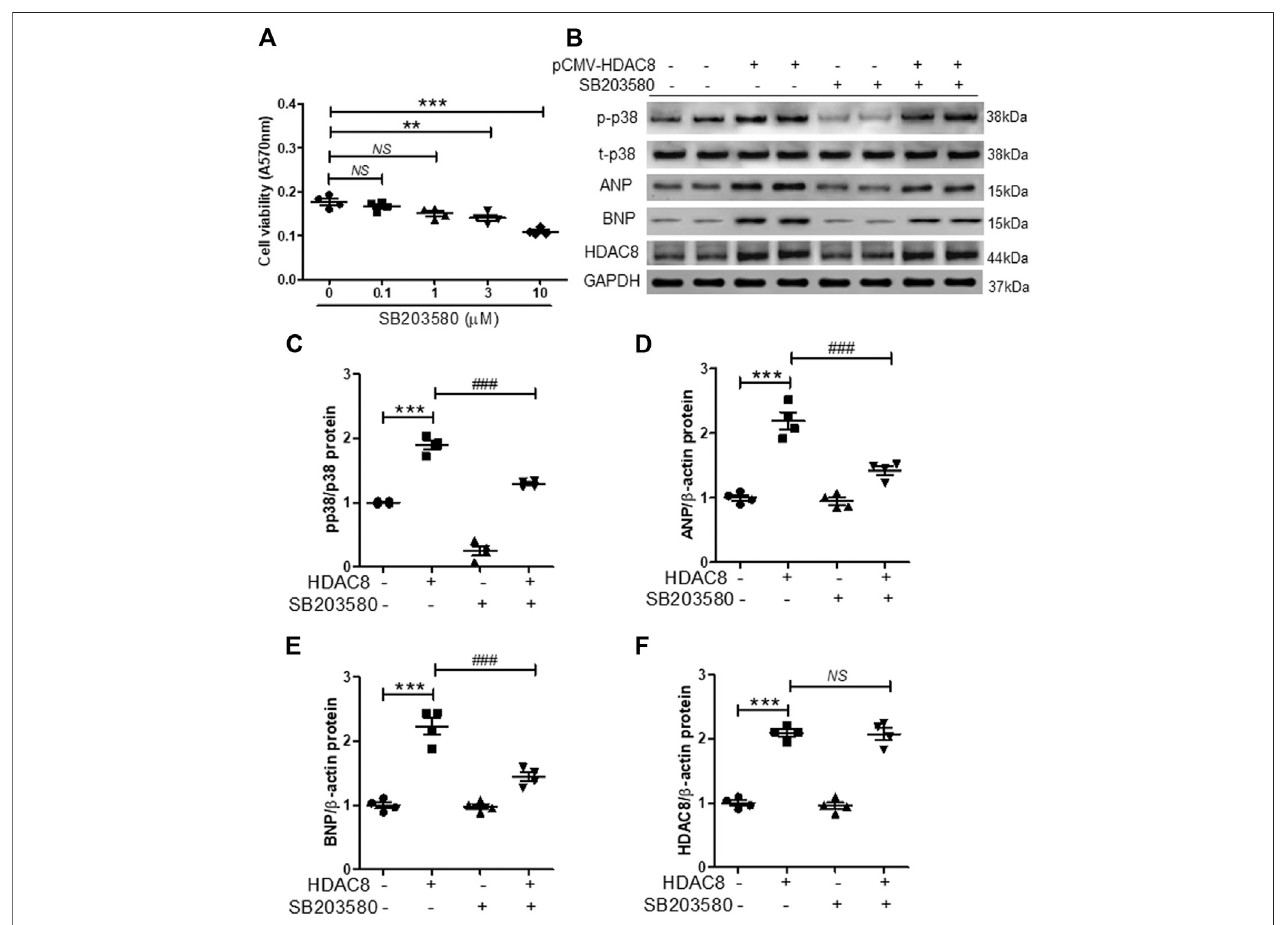
FIGURE 7 | Inhibition of p38 MAPK reduces the expression of cardiac hypertrophic markers induced by HDAC8 overexpression (A) H9c2 cells were treated with SB203580 (0.1, 1, 3, and 10 μ M) for 24 h and cell viability was evaluated ( n (cid:2) 4). ** p < 0.01 and *** p < 0.001. NS (cid:2) not signi fi cant (B) H9c2 cells were transfected with either pCMV6-HA-Myc or pCMV6-HDAC8-HA-Myc and treated with SB203580 (1 μ M) for 24 h. Representative western blot images of p-p38, t-p38, ANP, BNP, and HDAC8 (C − F) Quanti fi cation of p-p38, ANP, BNP, and HDAC8 protein levels ( n (cid:2) 4). *** p < 0.001; ### p < 0.001. NS (cid:2) not signi fi cant.